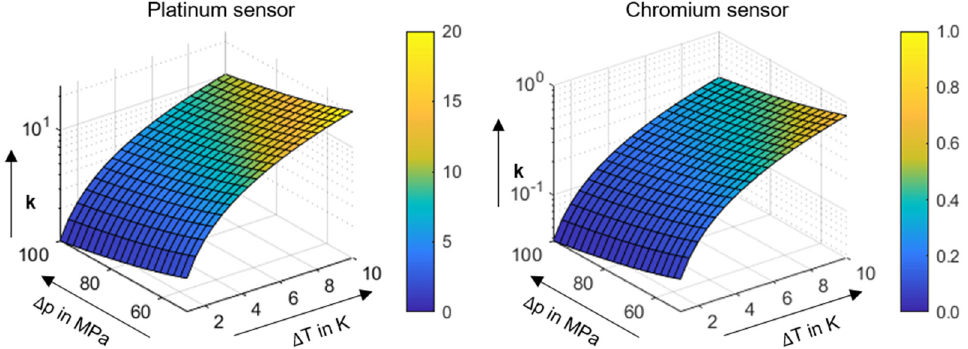
Figure 4. Ratio k of temperature and pressure-dependent resistance change for the platinum ( left ) and chromium ( right ) thin-film sensor.